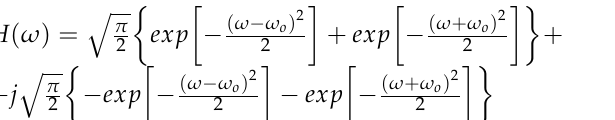
Figure 6. Morlet wavelet: solid line-real part, dashed line-imaginary part.